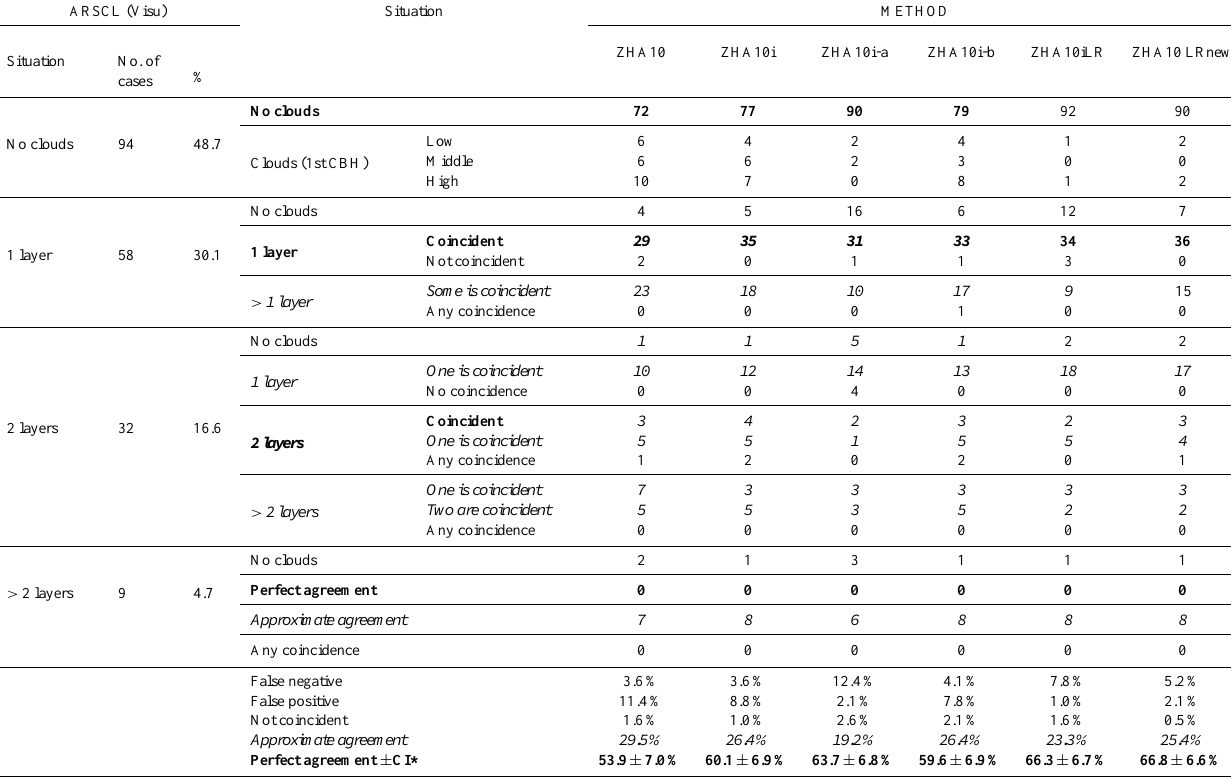
Table 6. Behavior of the tests performed on the ZHA10 method compared to ARSCL observations. Data in bold account for “Perfect agreement” cases; data in italics account for “Approximate agreement” cases.